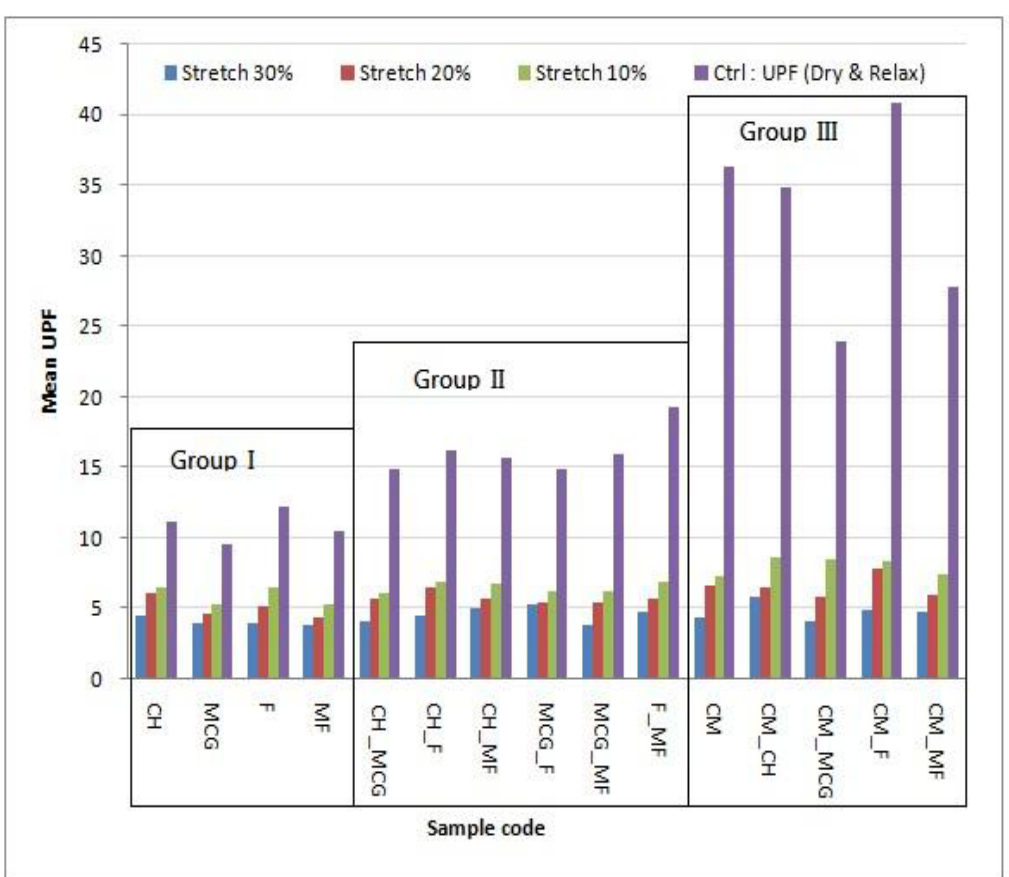
Figure 4. Overall performance on UPF under 3 different stretch